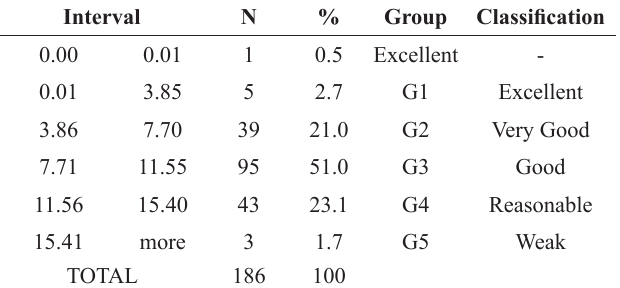
Table 5. Index created for classification of females.